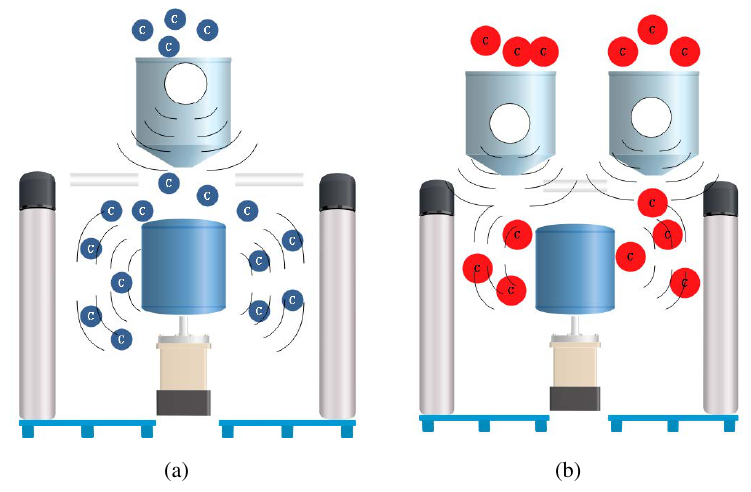
Fig. 1 The working principle diagram of general impact crusher and two-flow